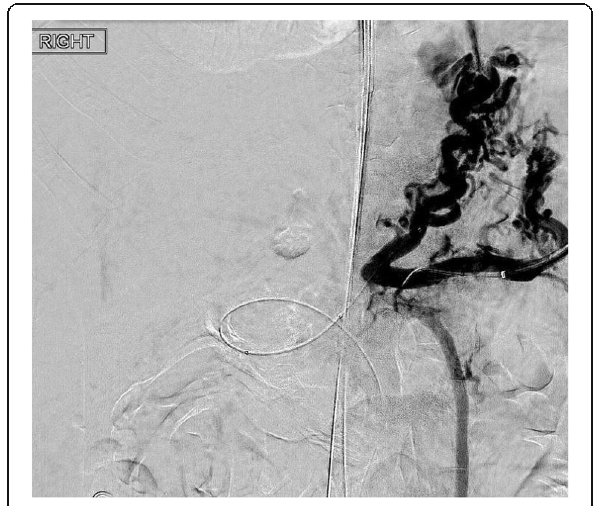
Fig. 2 Splenic venogram demonstrating drainage of splenic vein into gastric varices and non visualization of portal vein